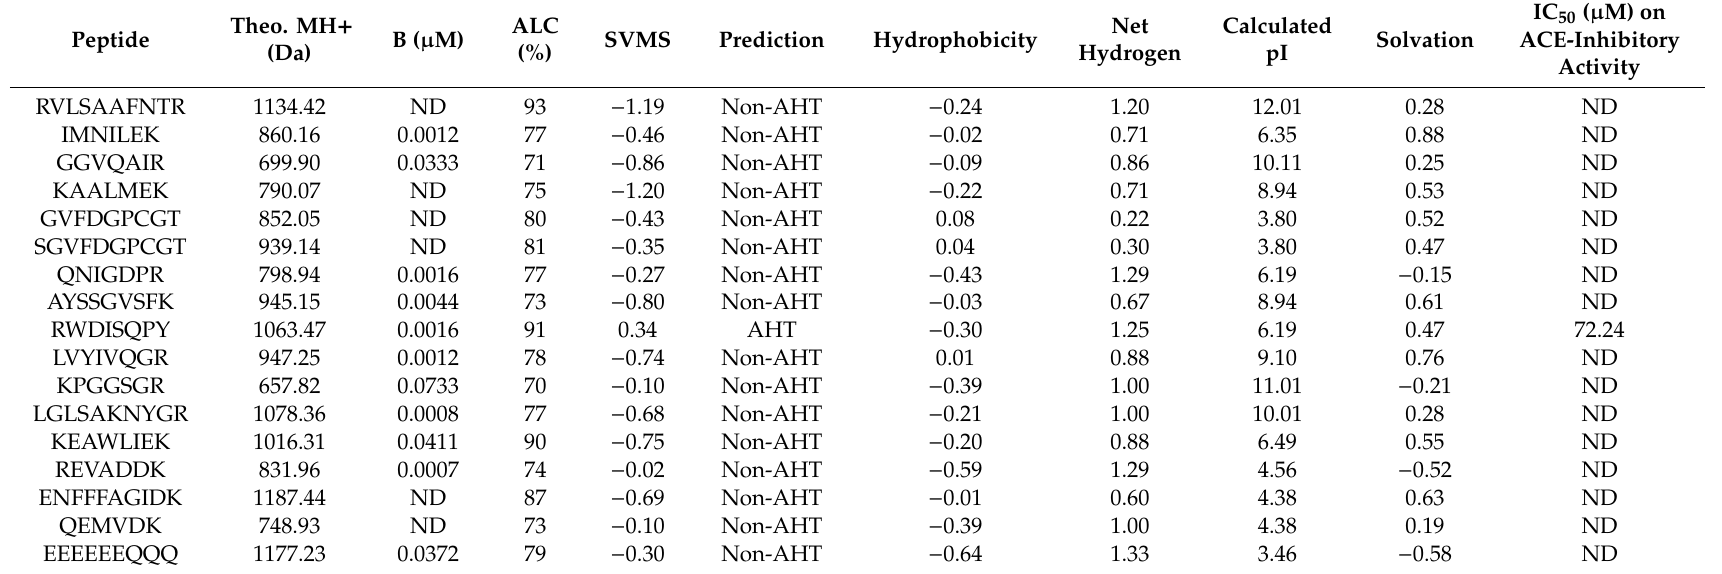
Table 2. Predicted ACE-inhibitory activity and physicochemical properties identified in S. maclurei protein hydrolysates by LC–ESI–MS / MS and screening in silico. Theo. MH + Peptide